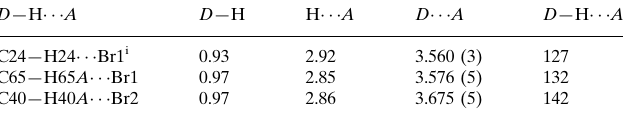
Hydrogen-bond geometry (A˚ , (cid:2)